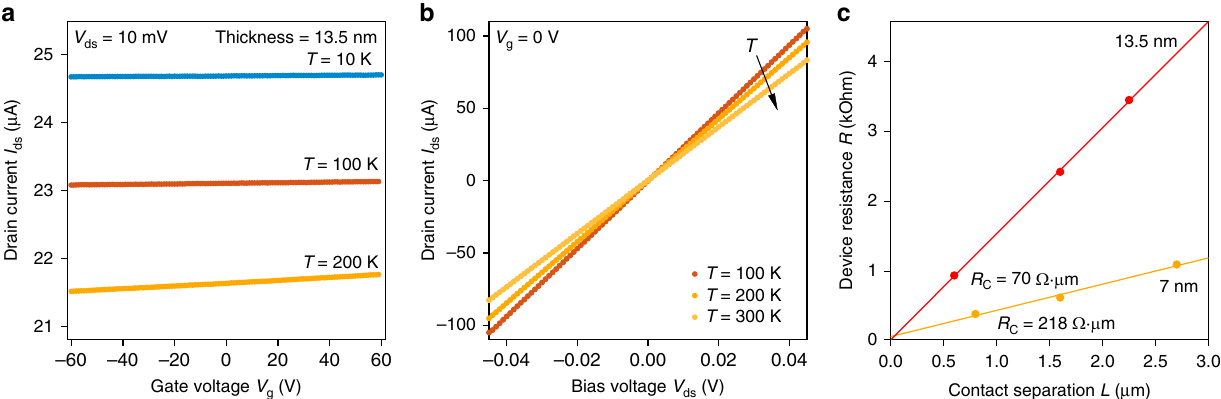
Fig. 2 Electrical transport characterization of 13.5 nm thick PtSe 2 . a Gating characteristics showing weak current modulation at different temperatures. b I ds − V ds curves acquired at different temperatures. c Contact resistance extraction using the transfer length method for the 13.5 and 7 nm